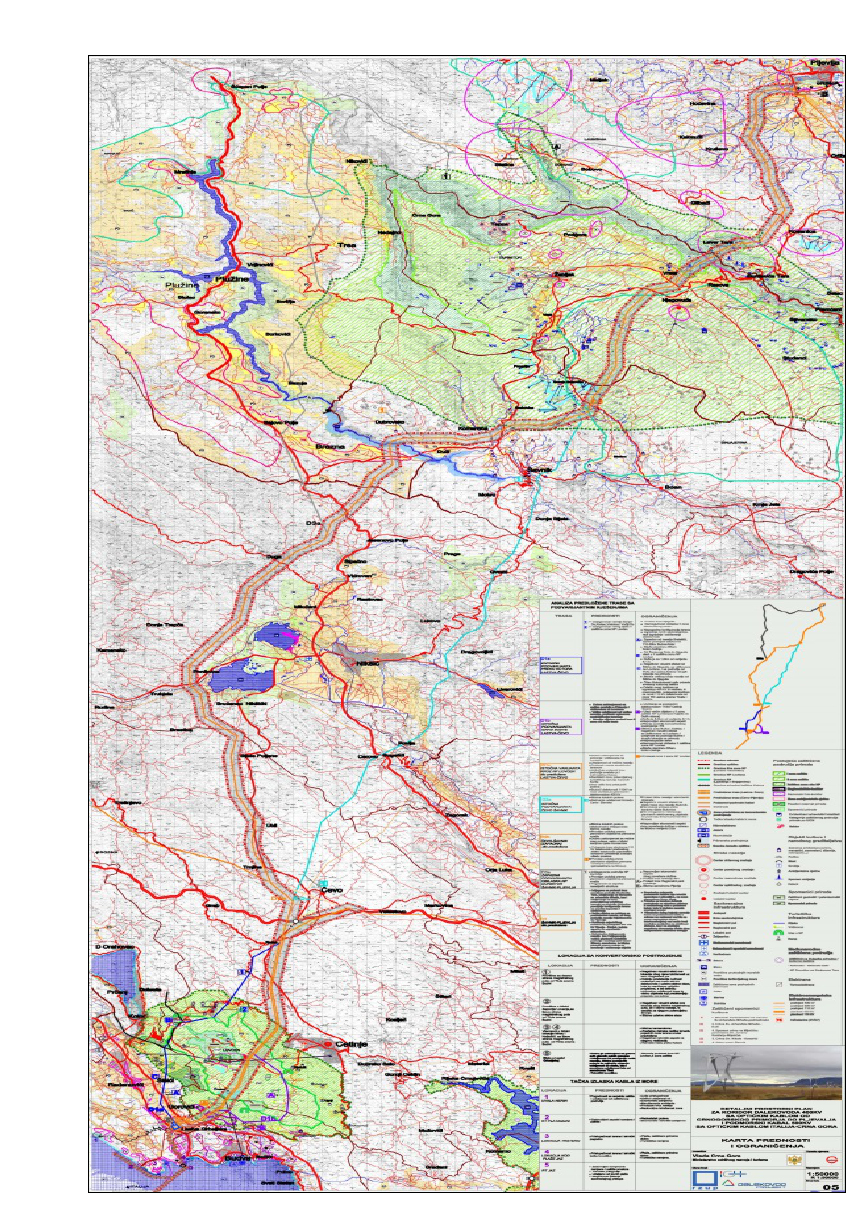
Figure 2 – Overview and a reduced scale map from the report on the environmental impact with a detailed analysis of the impact (Government of Montenegro, 2007b) Slika 2 – Pregledna i umanjena karta izveštaja о uticaju na životnu sredinu sa detaljnom analizom (Government of Montenegro, 2007b) Рис . 2 – Обзорная мелкомасштабная карта с анализом воздействия на окружающую среду ( Правительство Черногории ,